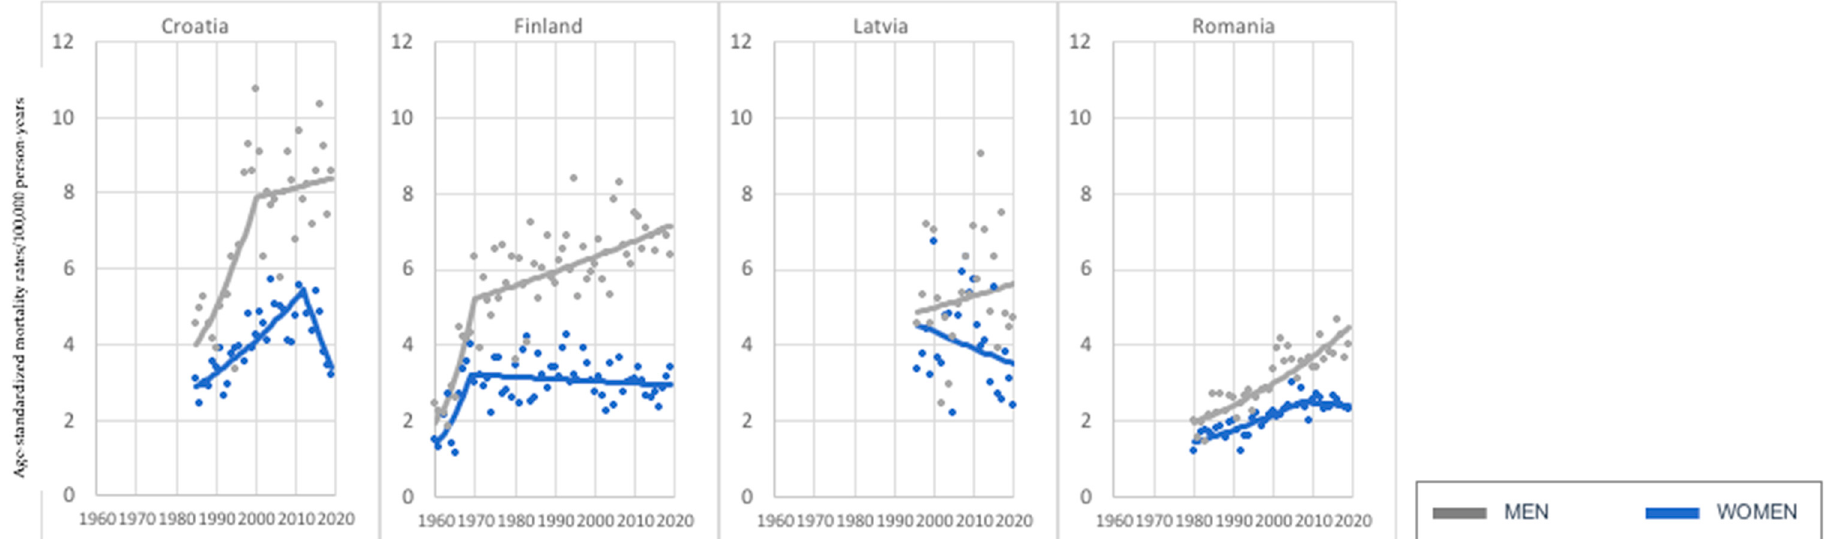
Figure 4. Melanoma mortality trends—4 countries with an investigated decrease in women and increase in men, age group 45–74 years old.